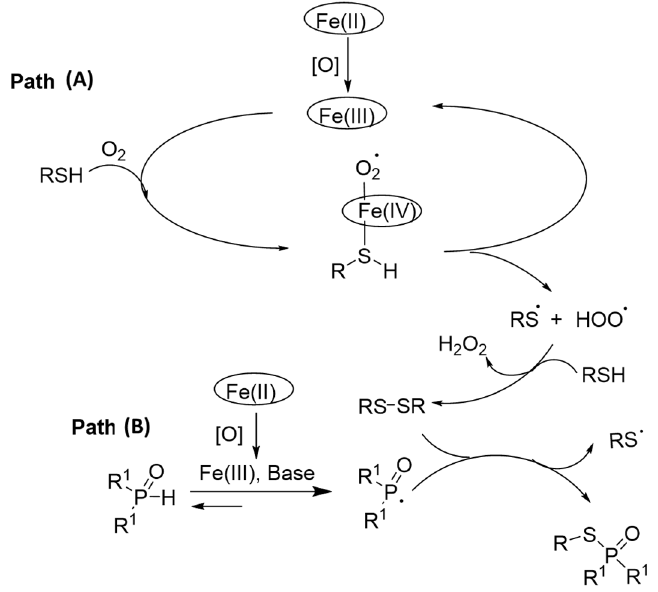
Figure 16. Proposed mechanism for cross-dehydrogenative coupling (CDC) of thiols with H-phosphonates and H-phoshine oxides (adapted from [64]). Solid base catalysts obtained from the noncovalent attachment of the tetrasulfonated cobalt(II) phthalocyanine Co(II)Pc(SO 3 H) 4 to graphene oxide (GO) functionalized with